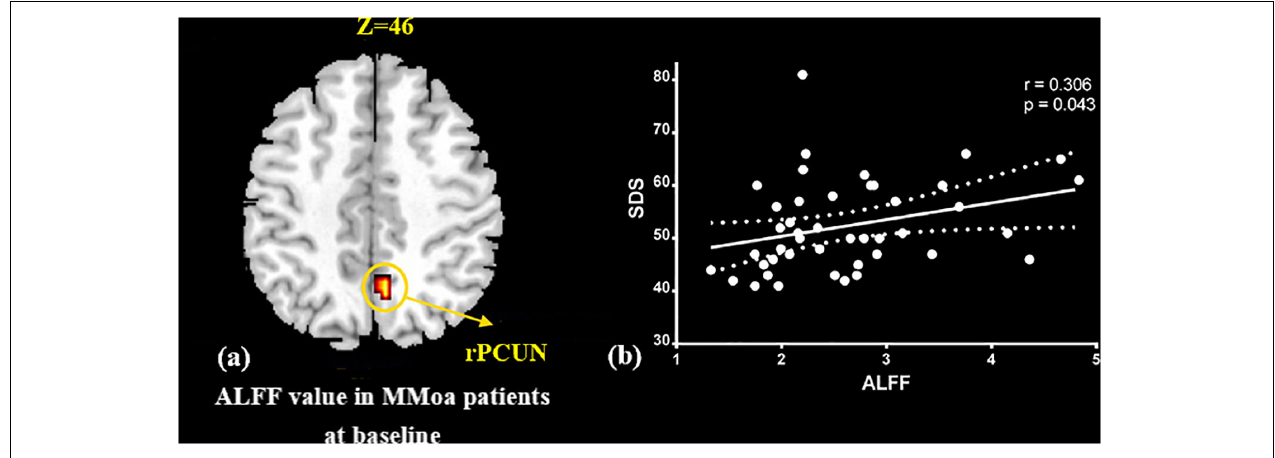
FIGURE 1 | Correlation analysis between ALFF value in precuneus and SDS in the MMoA patients ( p < 0.05, FDR corrected). (a) Brain region used for the correlation analysis shown. (b) ALFF in the precuneus was positively correlated with SDS. PCUN, precuneus; R, right; SDS, Zung self-rating depression scale.